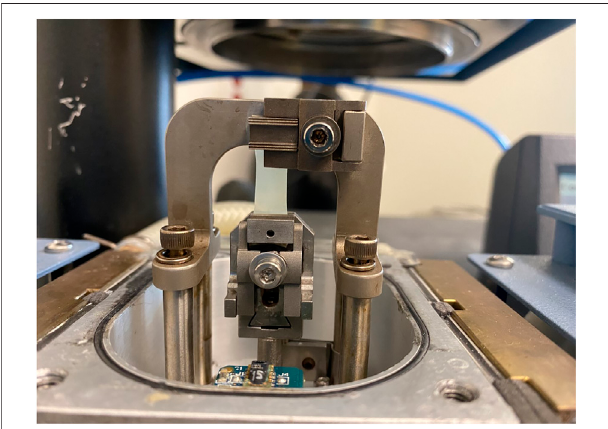
FIGURE 3 | Illustration of a membrane sample in clamps of a